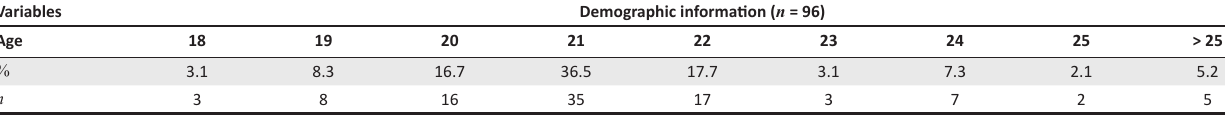
TABLE 1a: Summary of the demographic information of the participants.